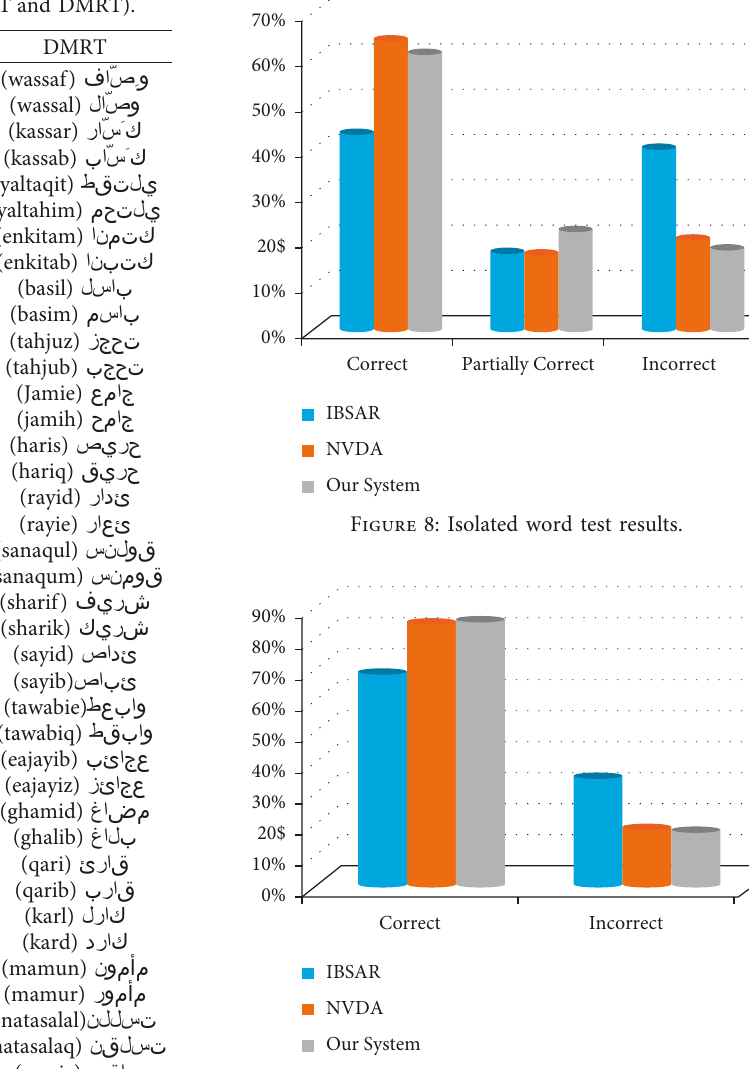
Figure 9: Homograph test